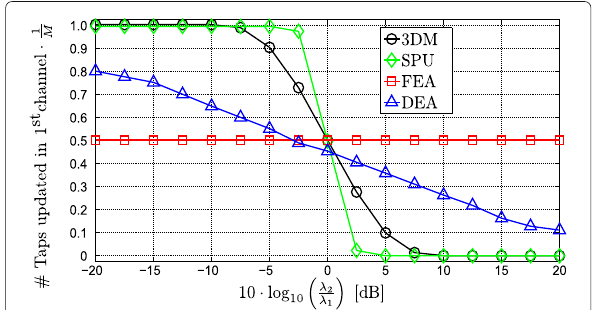
Fig. 8 Effect of the inter-channel power ratio of a stereo white noise signal on the number of taps allocated to the sub-filters in the first channel (as a fraction of M taps allocated to both channels) when using the 3DM, SPU, FEA, and DEA tap selection schemes ( Q = 0.2)